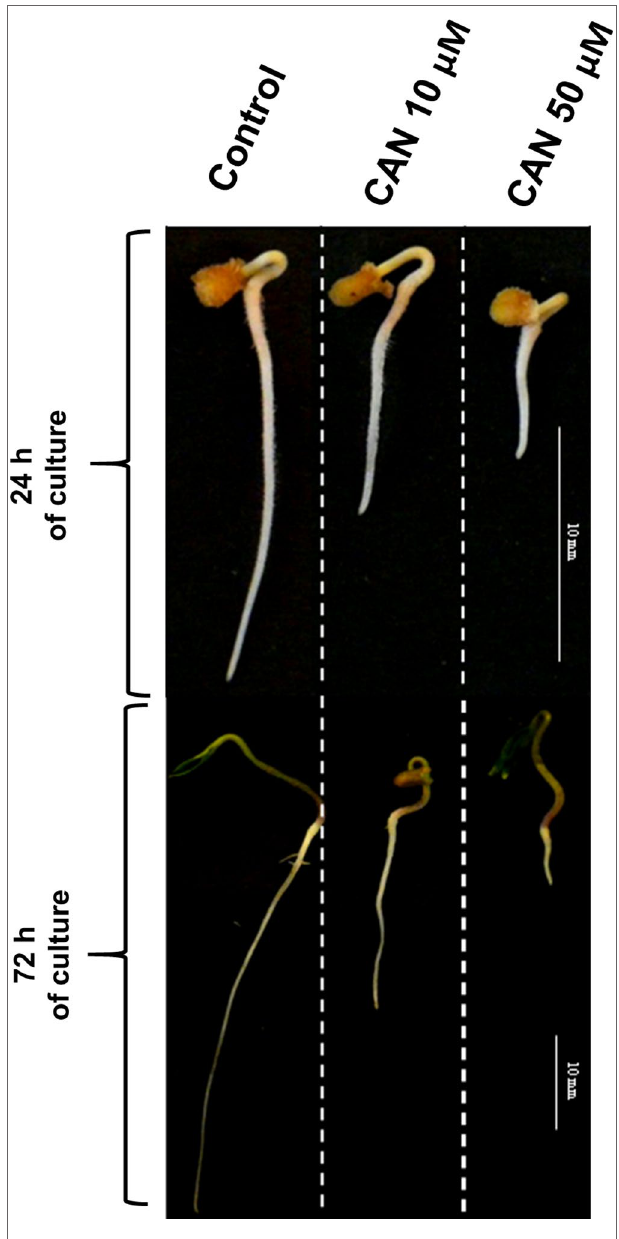
FIGURE 1 | Tomato seedlings grown for 24 or 72 h in water (control) or CAN aqueous solutions (10 or 50 µM). Images of representative seedlings are